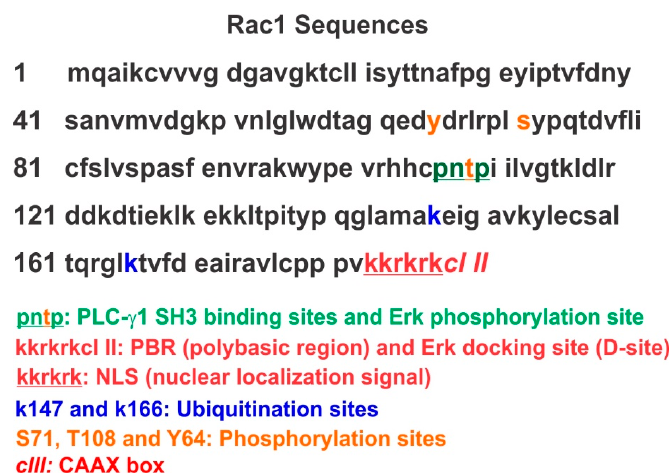
Figure 2. Rac1 sequences, various motifs, and amino acid residues subjected to the post-translational